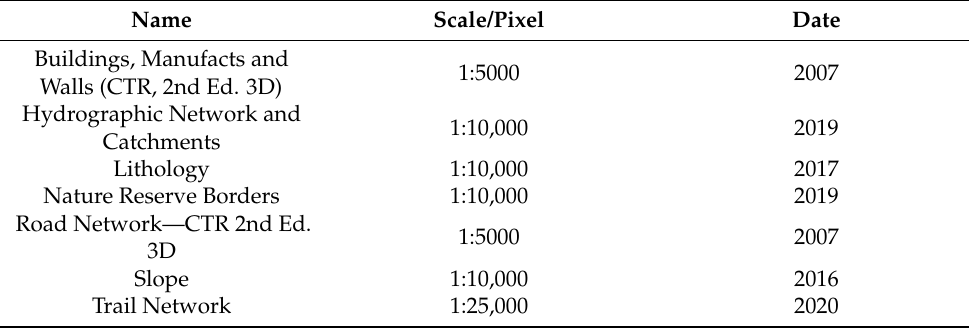
Table 1. Vector-based data used; source is from Regione Liguria